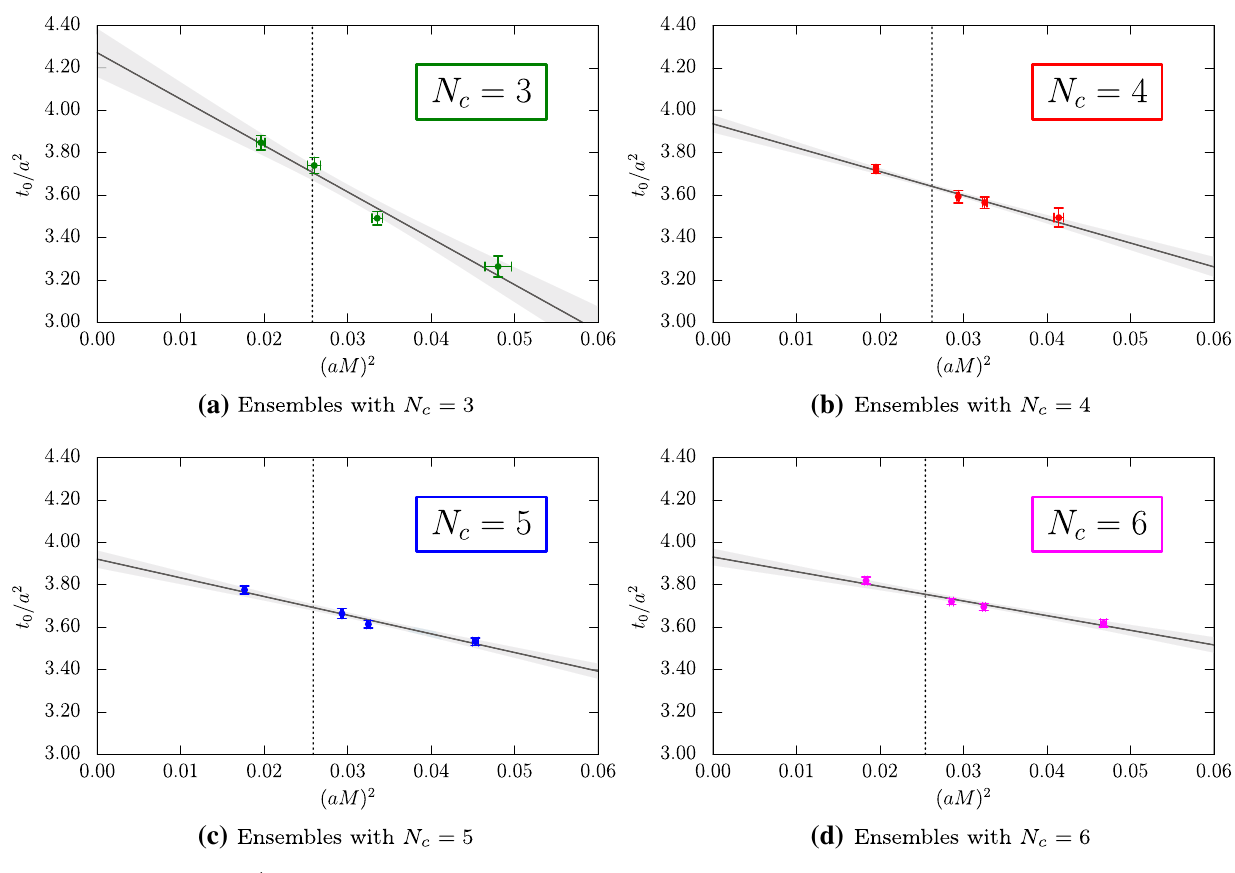
/ a 2 . The vertical line corresponds to the value M 2 = M 2 0